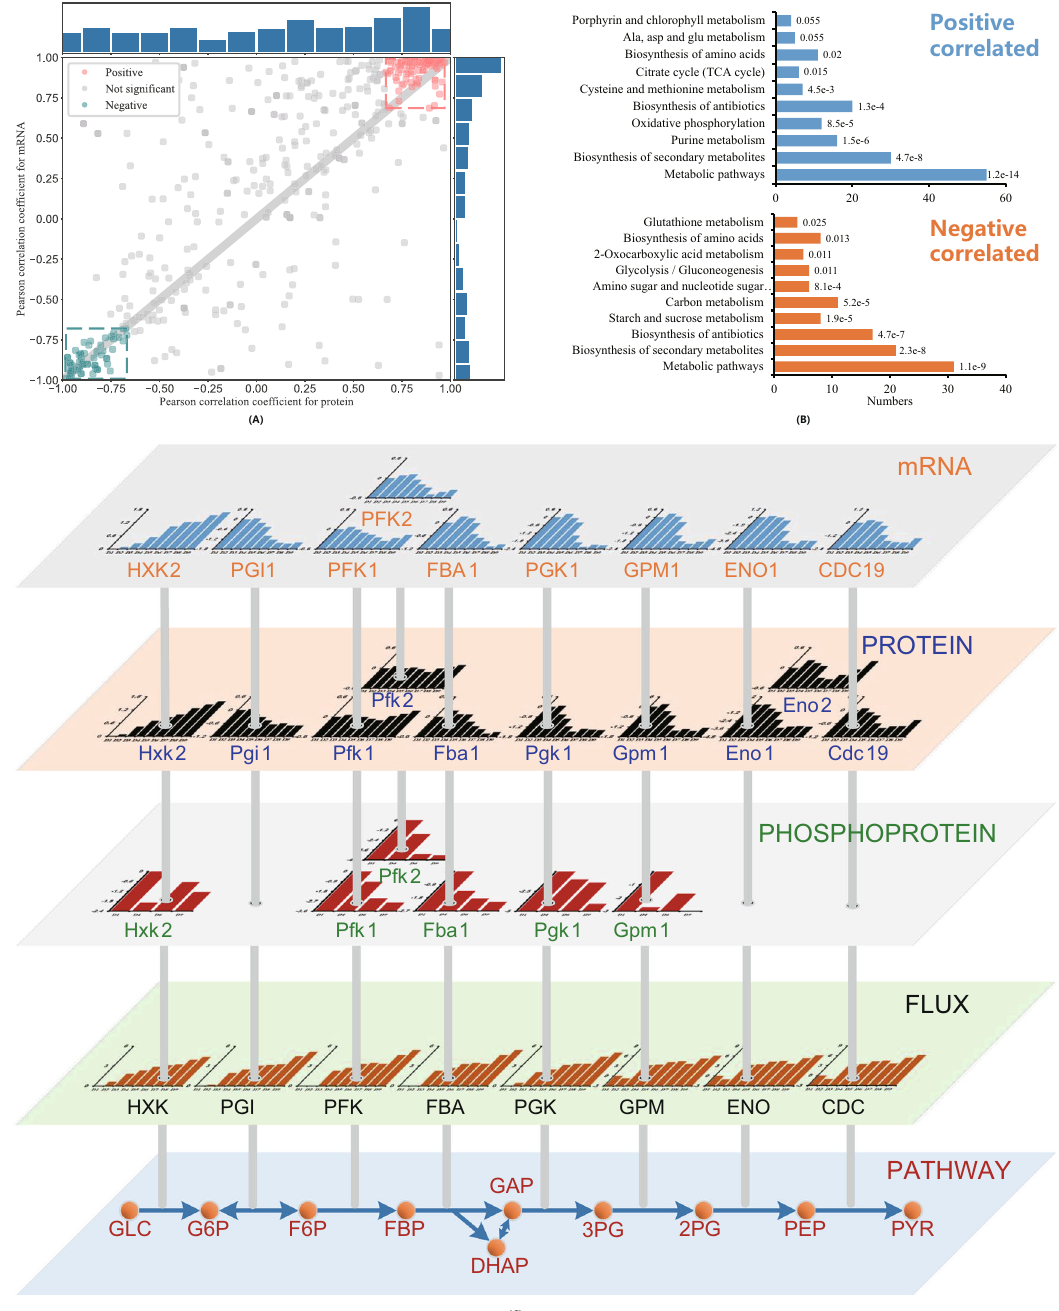
Fig. 3 Correlation analysis between reaction fl uxes and abundances of the corresponding mRNA and protein. A Pearson correlation coef fi cients for both mRNA/ fl ux and protein/ fl ux pairs, with the distribution of Pearson correlation coef fi cients for protein/ fl ux pairs shown on the right margin and for mRNA/ fl ux pairs shown on the top margin. B Pathway enrichment analysis for both signi fi cantly positively correlated and negatively correlated reactions. Figures above each bar are adjusted p values. C Overview of EMP pathway reactions with changes in absolute reaction fl uxes, protein phosphorylation levels, absolute protein abundance and absolute mRNA abundance. The abscissas for all bar plots are speci fi c growth rates of yeast cells. Details of the bar plots included in this panel can be found in the Supplementary Information. Source data are provided as a Source Data fi Enzyme saturation plays an important role in ful fi lling amino for e (enzyme regulation coef fi cient), m (metabolite regulation acid biosynthesis demand as yeast cells grow faster . Hierarchical coef fi cient), t (transcript regulation coef fi cient), or p (protein regulation analysis can be used to decipher at which level a phosphorylation regulation coef fi cient). According to the analysis reaction is regulated under both steady state and dynamic by ref. 33 , when 0.5 < ρ e < 1.5, the reaction fl ux is regulated mainly by enzyme abundance. Pairwise hierarchical analysis, taking the conditions 36 . Flux regulation contributions of enzymes, metabo- slowest speci fi c growth rate 0.027 h − 1 as the reference, was used lites, transcripts, or posttranslation modi fi cations can be deter- to calculate ρ e based on the proteome and fl uxome data with both mined by hierarchical regulation coef fi cients ρ i , with i standing